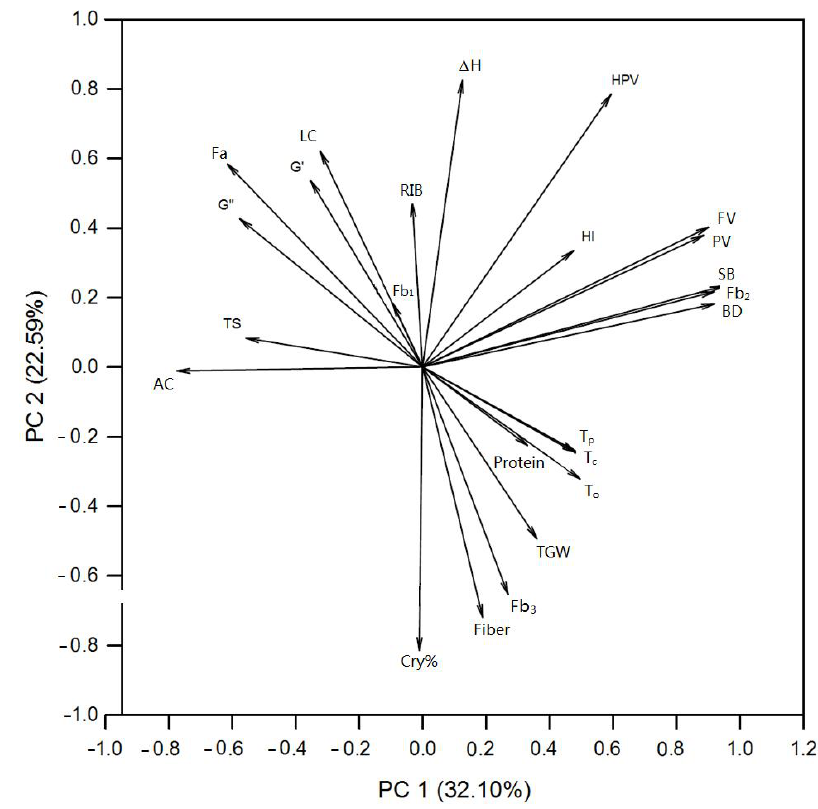
Figure 6. Principal components analysis of various properties of wheat varying in grain hardness index.